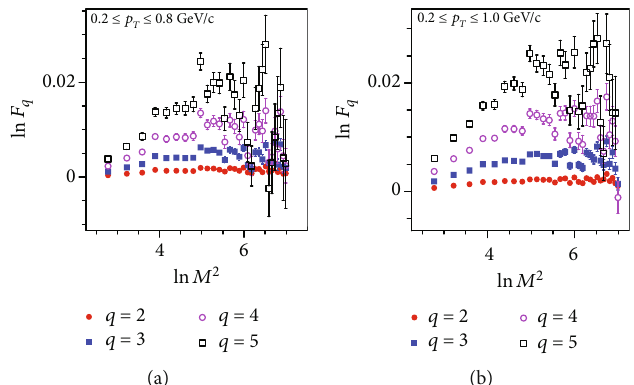
M 2 ) for EPOS3-hydro+cascade events for the p